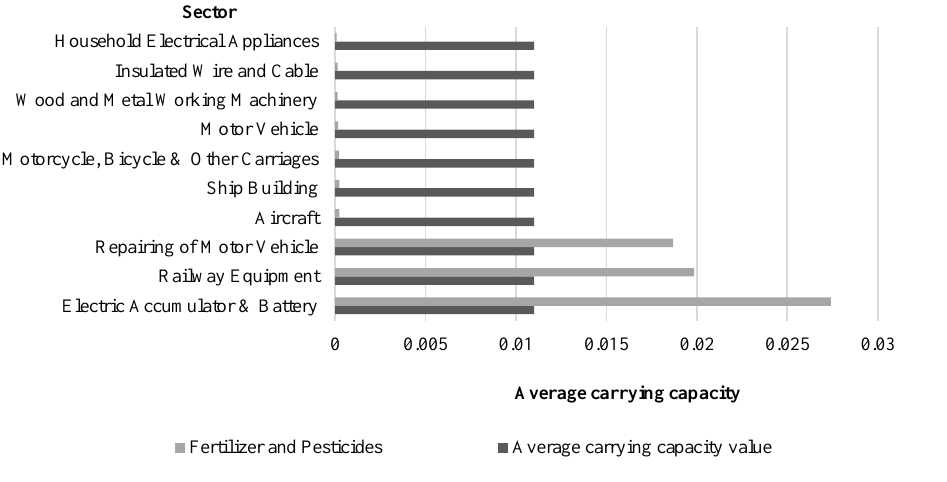
Fig. 5. Fertilizer and Pesticides